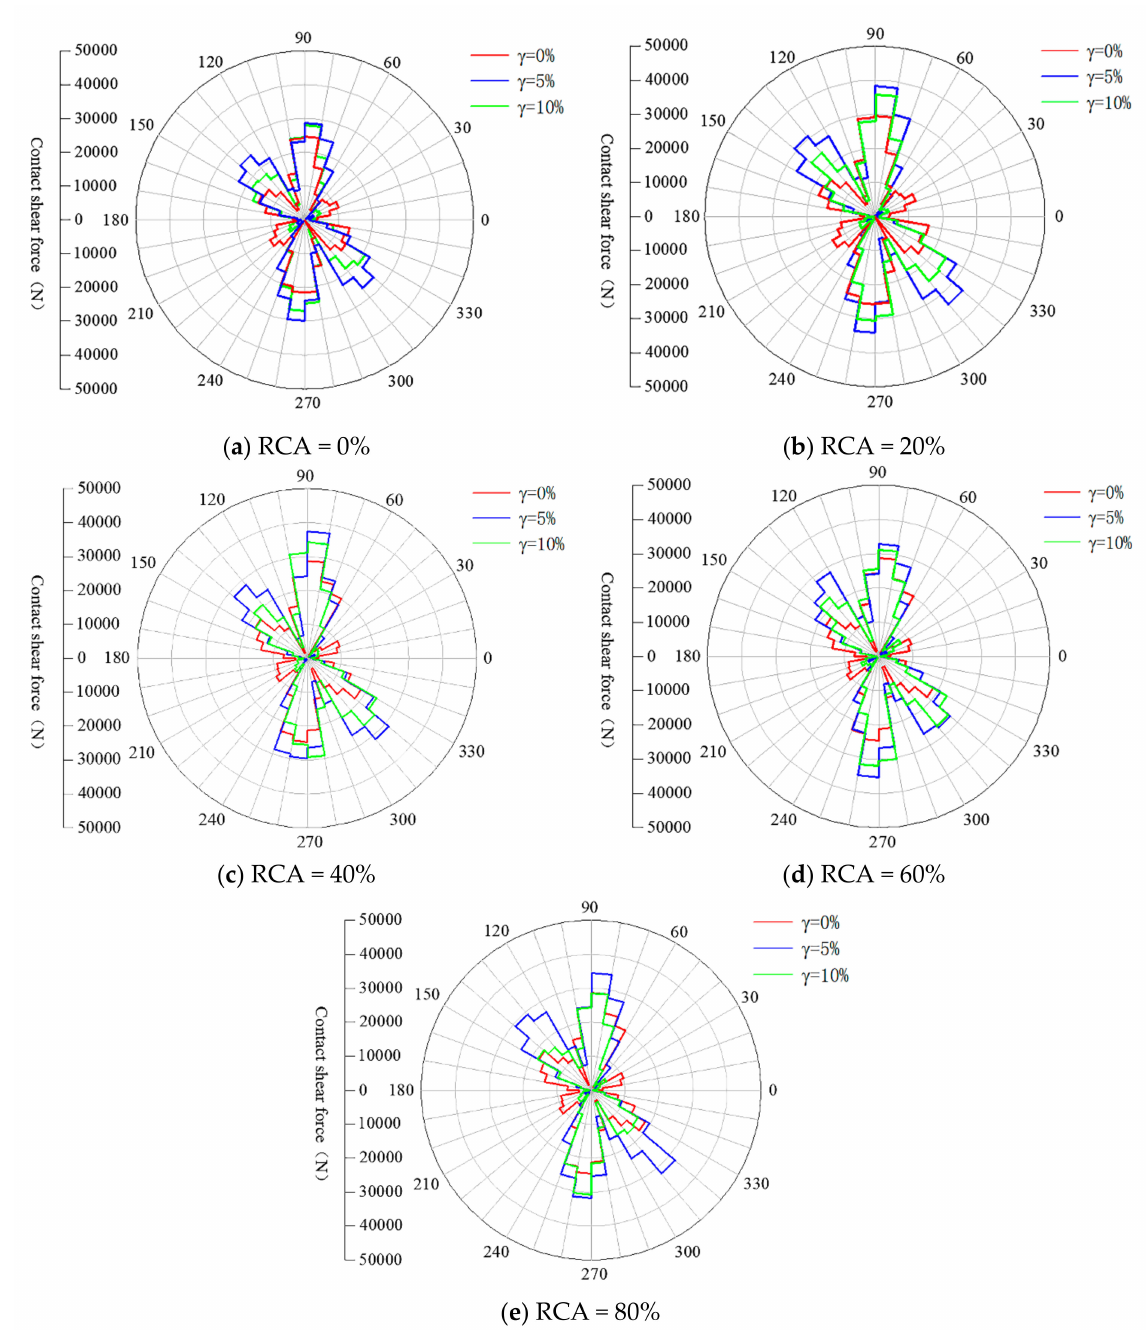
Figure 17. The anisotropies of shear contact force of samples with various RCA contents in different shear states: ( a ) RCA = 0%; ( b ) RCA = 20%; ( c ) RCA = 40%; ( d ) RCA = 60%; and ( e ) RCA =